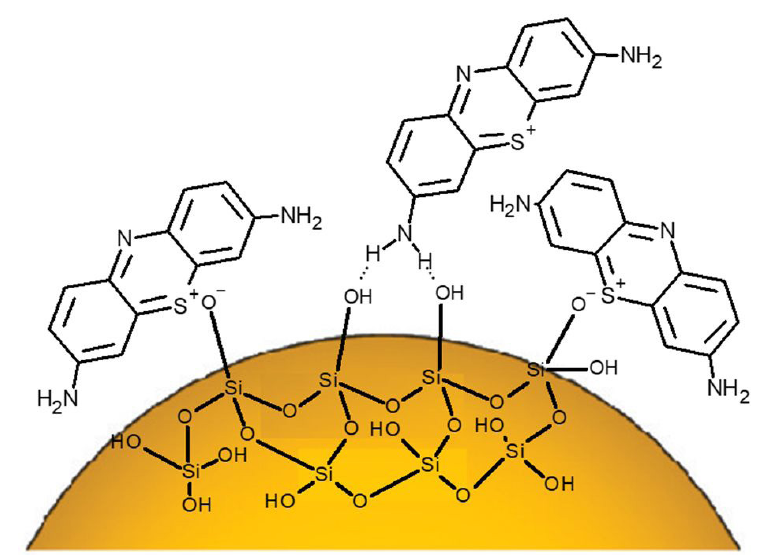
Figure 11. Proposed mechanism of MB adsorption by PMF-Si